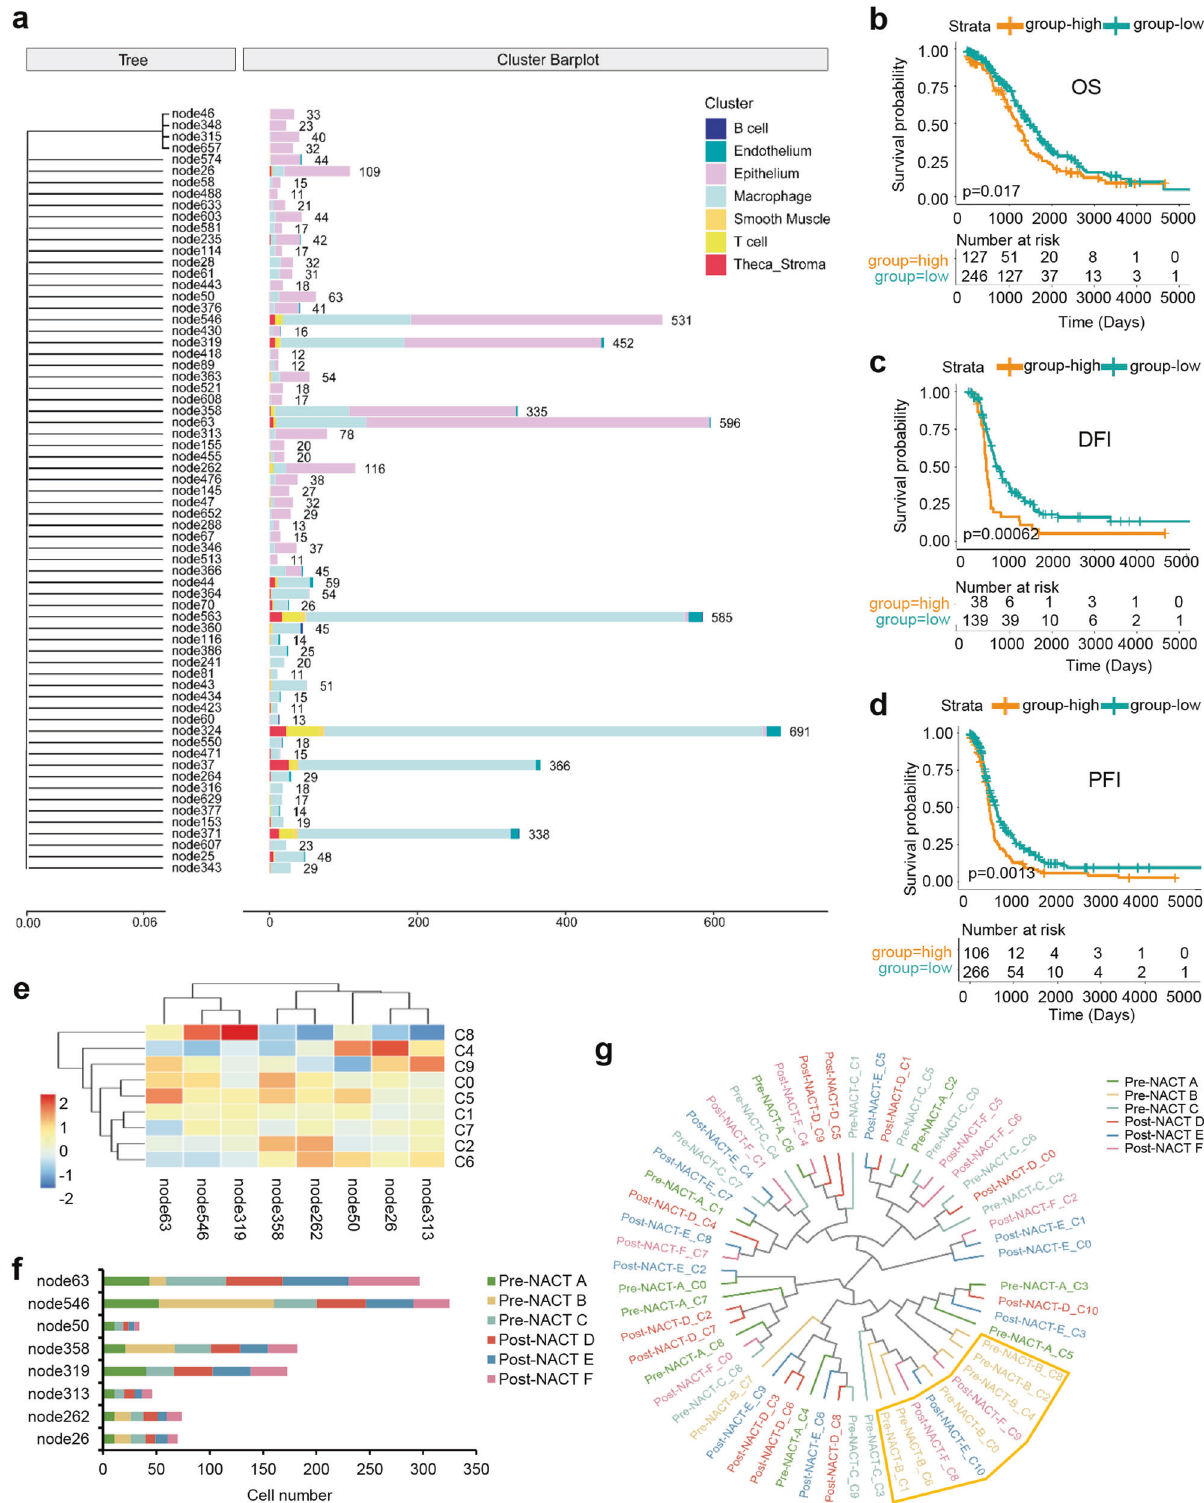
Fig. 4 Analysis of clonal evolution in high-grade serous fallopian tube carcinoma tissues following NACT treatment. a Phylogenetic trees showing the analyses of the clonal dynamics calculated from each cell type, and the subpopulation-speci fi c differences in each clone are indicated with color-coded bars. Kaplan – Meier survival curves for OS ( b ), DFI ( c ) and PFI ( d ) from TCGA HGSC data showing signi fi cant prognostic separation according to the clone 63 marker gene signatures from our scRNA-seq data. Log-rank p values are shown. e Clonal frequencies of the eight main clone cells are annotated in each epithelial subcluster. f The cell number distribution of the eight main clones in each tumor sample. g Evolutionary tree analysis showing the distribution of epithelial subclusters and corresponding tissue samples. DFI disease-free interval; PFI progression-free